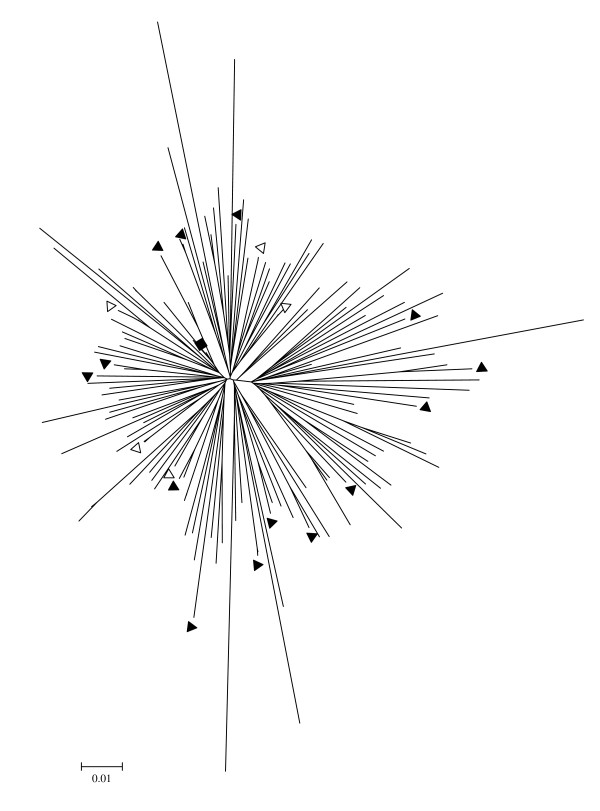
Neighbor-joining genetic analysis of the phylogenetic tree of the HIV-1 CRF07_BC isolates. The viral env sequences were obtained by PCR analysis of plasma samples of 124 HIV-1 infected patients, from whom the study subjects were selected."black square" represents the consensus env sequence of CRF07_BC strains circulating in China. Blood samples were collected from the HIV-1-infected patients and used for isolation of the CRF07_BC isolates with (black triangle) or without (open triangle) in vitro infectivity.